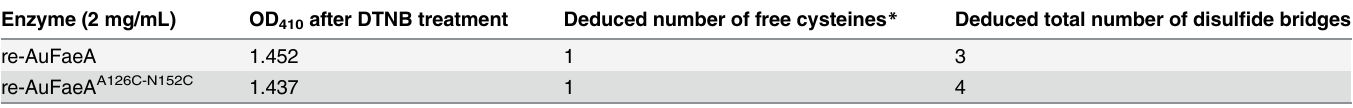
Table 2. Deduced number of free cysteines and disulfide bridges in re-AuFaeA and re-AuFaeA A126C-N152C . Enzyme (2